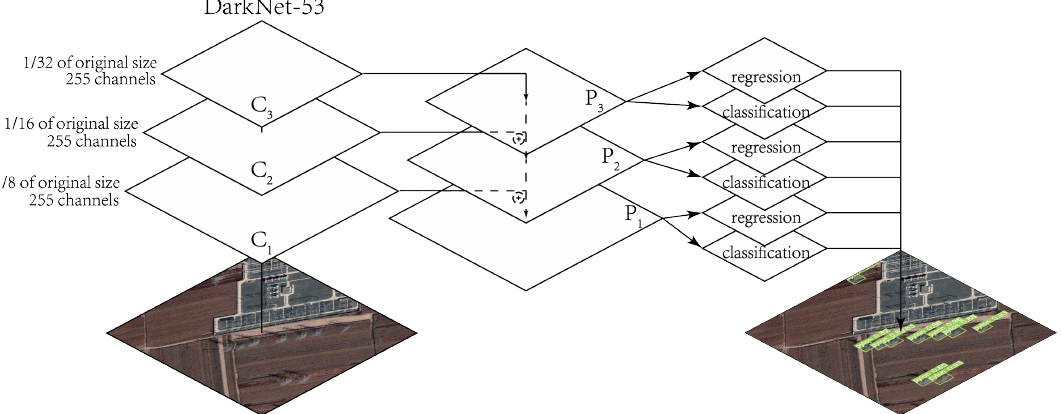
Figure 10. Structure of YOLOv3 [27]. Darknet-53 is a residual network mainly constructed of 1 × 1 and 3 × 3 convolution module. C 1 – C 3 refer to the feature layers of the last three scales obtained after five down sampling of the input image in Darknet-53. P 1 – P 3 are obtained from C 1 – C 3 feature layers after superimposition of adjacent layers through upper sampling. (cid:76) refers to the superimposition